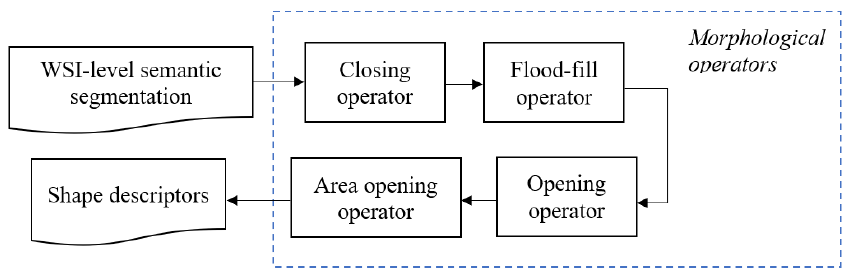
Figure 5. Morphological operators sequence applied to the output masks from the semantic segmentation network. The output of the morphological post-processing is used for calculating shape descriptors to eventually perform clustering.